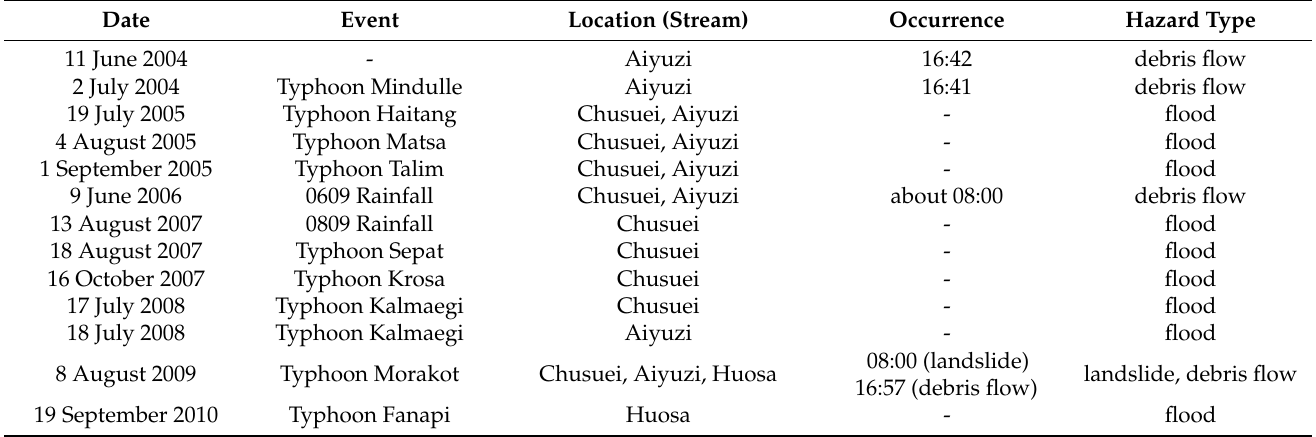
Figure 3. The data of 0713 Rainfall in 2011 ( a ) vibration signals ( b ) accumulated energy per second.